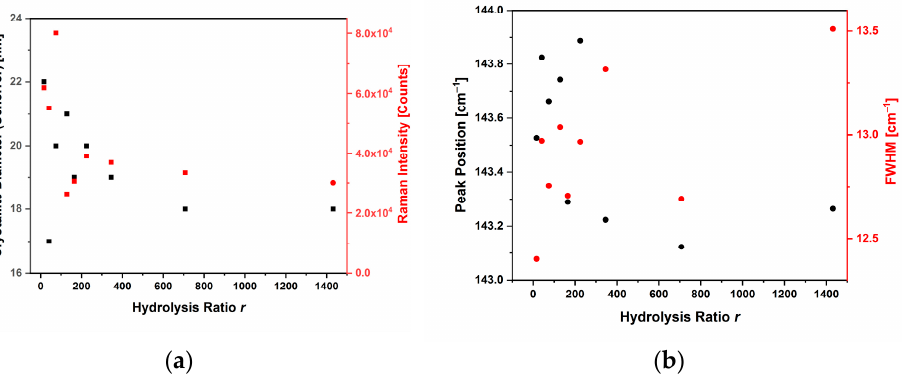
Figure 8. Plots correlating the crystallite diameter and intensity ( a ), position and width ( b ) of the Raman E g(1) peak, with the hydrolysis ratio used in the anatase basic synthesis.